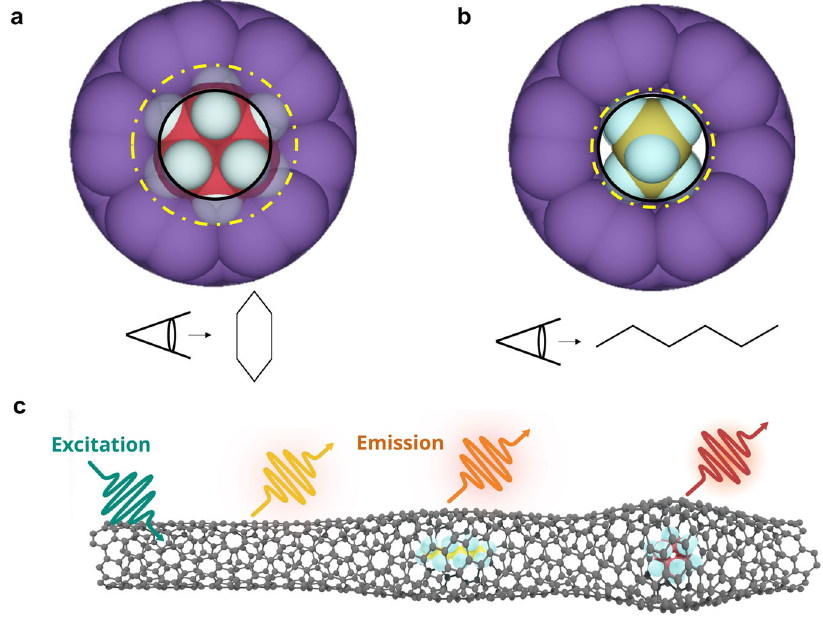
Fig. 1 Photoluminescence response of a carbon nanotube to encapsulated molecules. Cross-sectional views of a cyclohexane and b n-hexane with respect to a (6,5)-SWCNT (purple cylinder). The nanotube pore (as indicated by the black circle) is smaller than the molecule (as indicated by the dashed yellow circle). c The nanotube fl uoresces at different wavelengths in response to different encapsulated molecules. The yellow arrow represents the PL emission from un fi lled nanotube segments, while the PL emission from the fi lled positions are shifted depending on the encapsulated